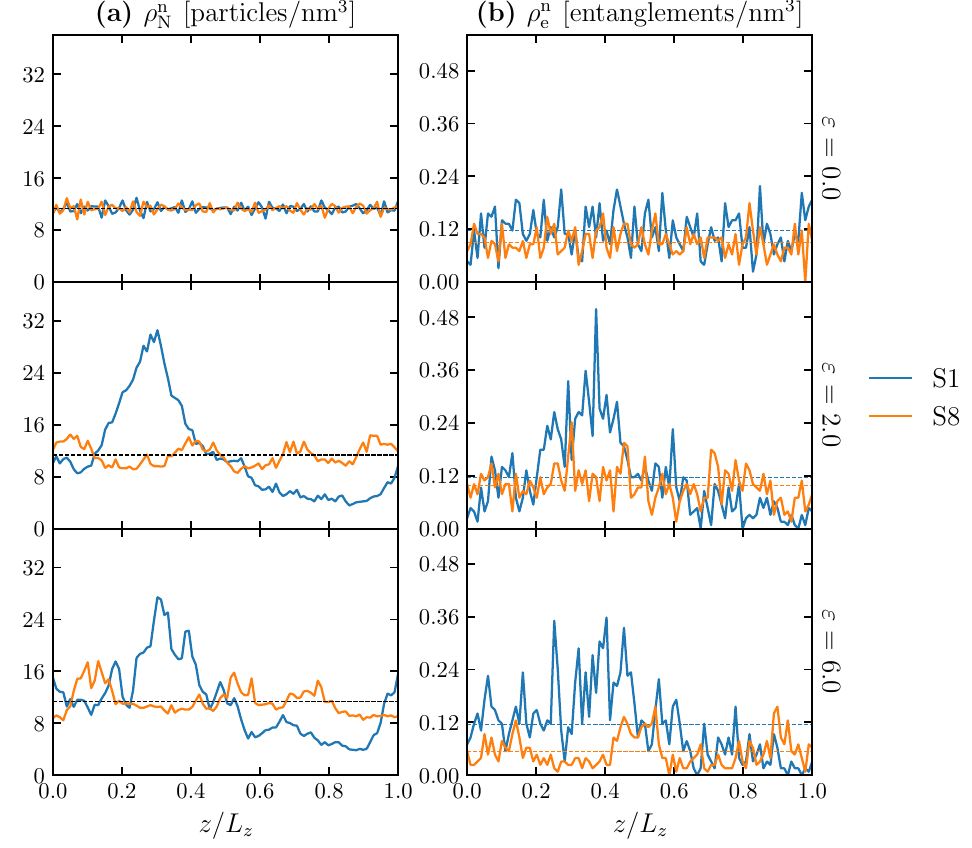
Figure 12. Distributions of ( a ) the nominal number density of particles ( ρ n number density of entanglement points ( ρ n e ) of 100 thin slices along the loading direction ( z -axis) for S1 (blue solid line) and S8 (orange solid line) at ε = 0.0, 2.0 and 6.0. The z -coordinate (abscissa) is normalized by the size of the simulation cell ( L z ). Note that L z changes during simulation because of tensile deformations. The dashed lines represent the arithmetic mean along the